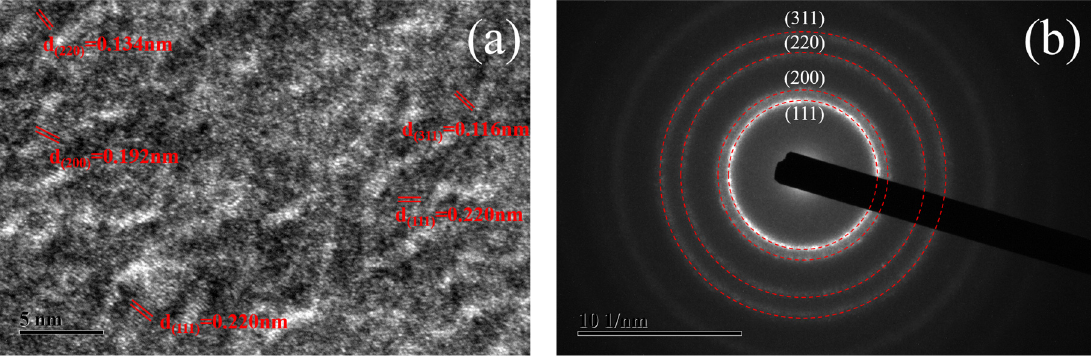
Figure 3. Transmission electron microscopy analysis of iridium coating: ( a ) Microphotographs, ( b ) electron diffraction pattern.